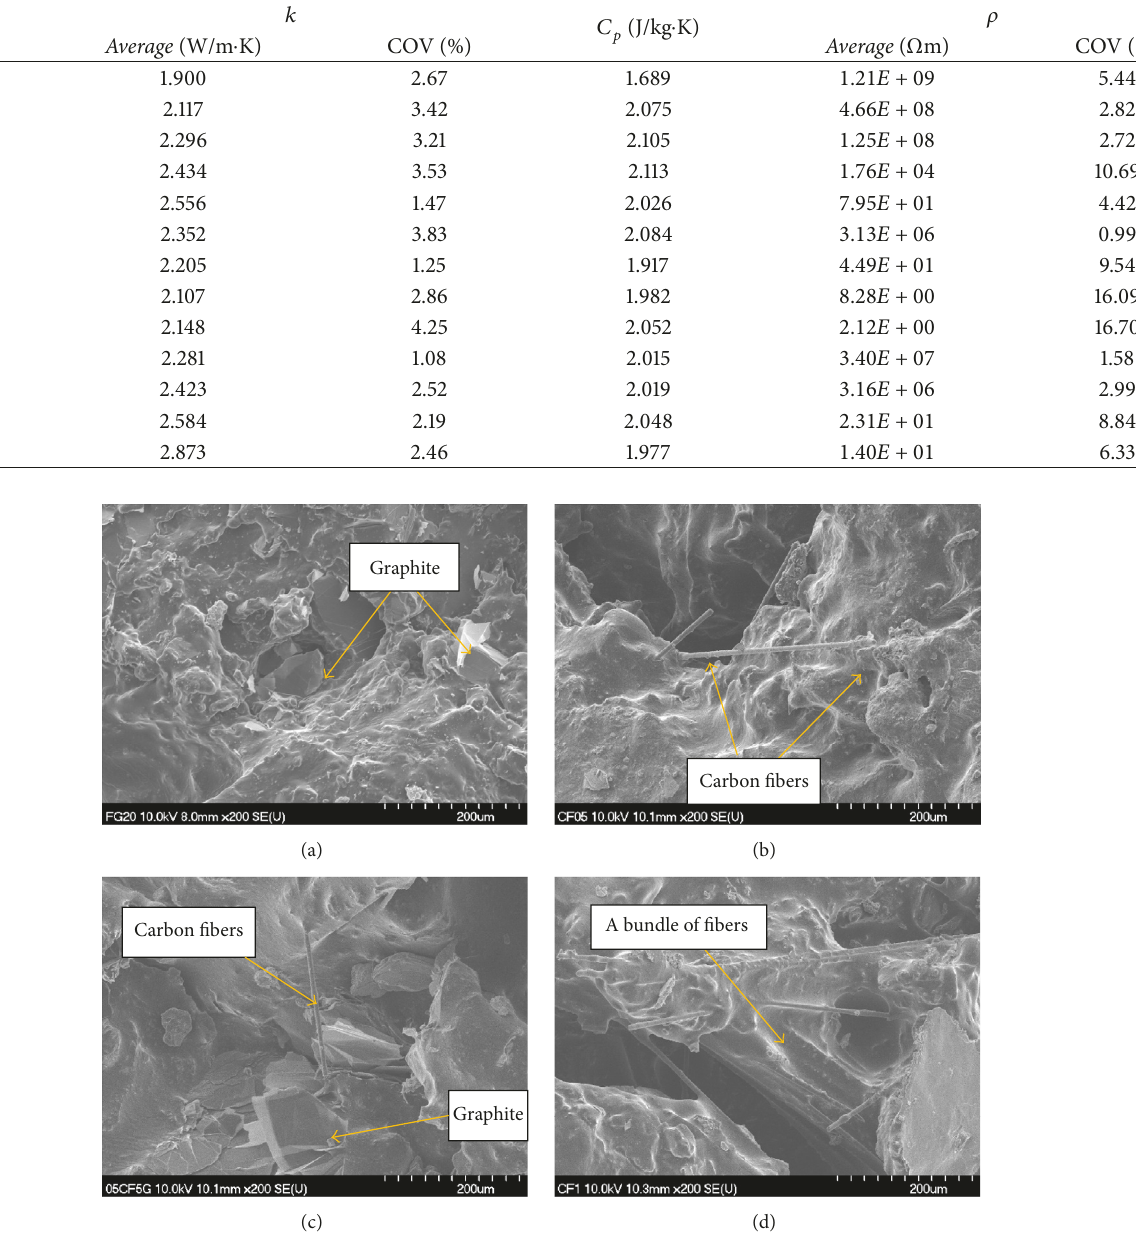
Figure 6: SEM images of asphalt mixture containing (a) graphite, (b) carbon fibers, (c) carbon fibers and graphite combined, and (d) carbon fibers in a